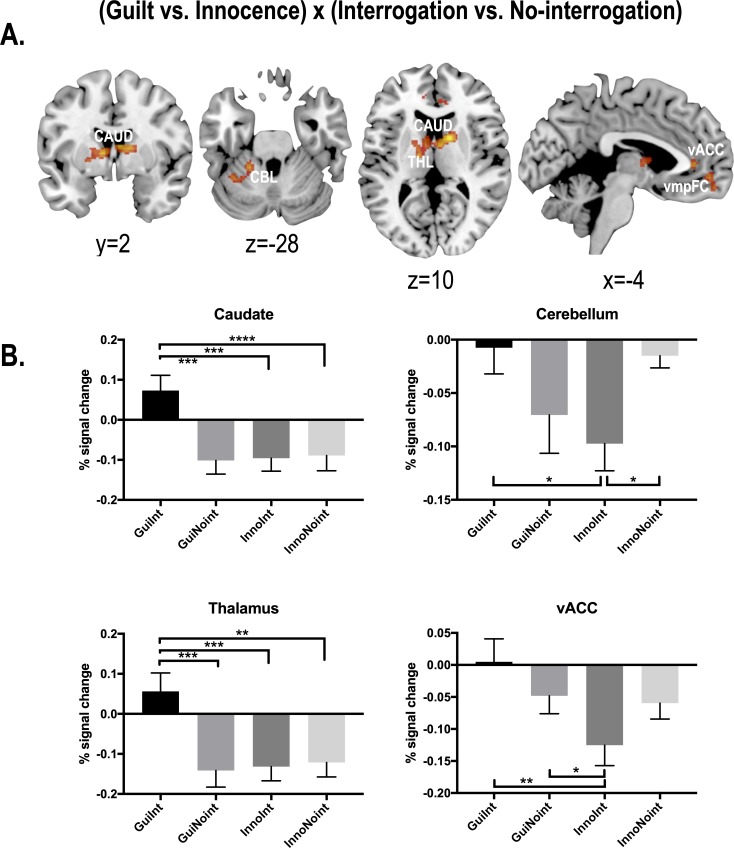
Statistical parametric maps for interaction between guilt vs. innocence and interrogation vs. no-interrogation.(A) Statistical map for interaction; (Guilt—Innocence) x (Interrogation—No-interrogation) displayed over slices. (B) Percent signal changes (mean and standard error) are displayed for GuiInt (guilt & interrogation), GuiNoint (guilt & no-interrogation), InnoInt (innocence & interrogation) and InnoNoint (innocence & no-interrogation) at the right caudate (x/y/z = 12/6/10), cerebellum (-20/-42/-26), left thalamus (-10/0/6) and left ventral anterior cingulate cortex (-2/40/4). *, ** and *** indicate p < 0.05, p < 0.01 and p < 0.001, respectively. CAUD: caudate, THL: thalamus, CBL: cerebellum, vACC: ventral anterior cingulate cortex, vmpFC: ventromedial prefrontal cortex. x,y, z indicates MNI coordinates in mm.